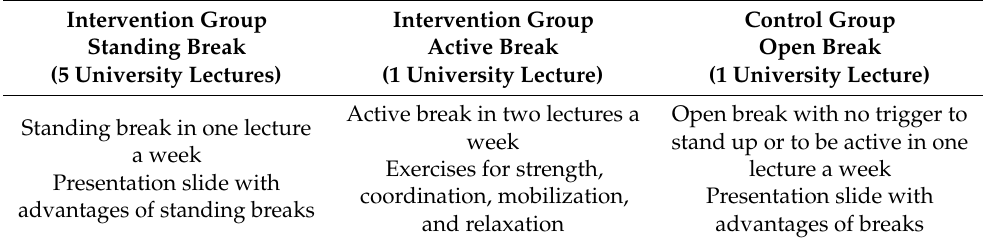
Figure 1. Presentation slide shown to the standing break intervention group as trigger to stand up.